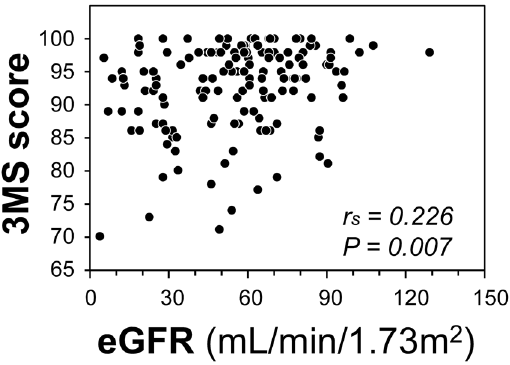
Figure 3. Correlation between eGFR and 3 MS total score in the total subjects. Abbreviations are: eGFR, estimated glomerular filtrationrate; 3 MS, Modified Mini-Mental State examination; r s , Spearman’s correlation coefficient; P, level of significance.